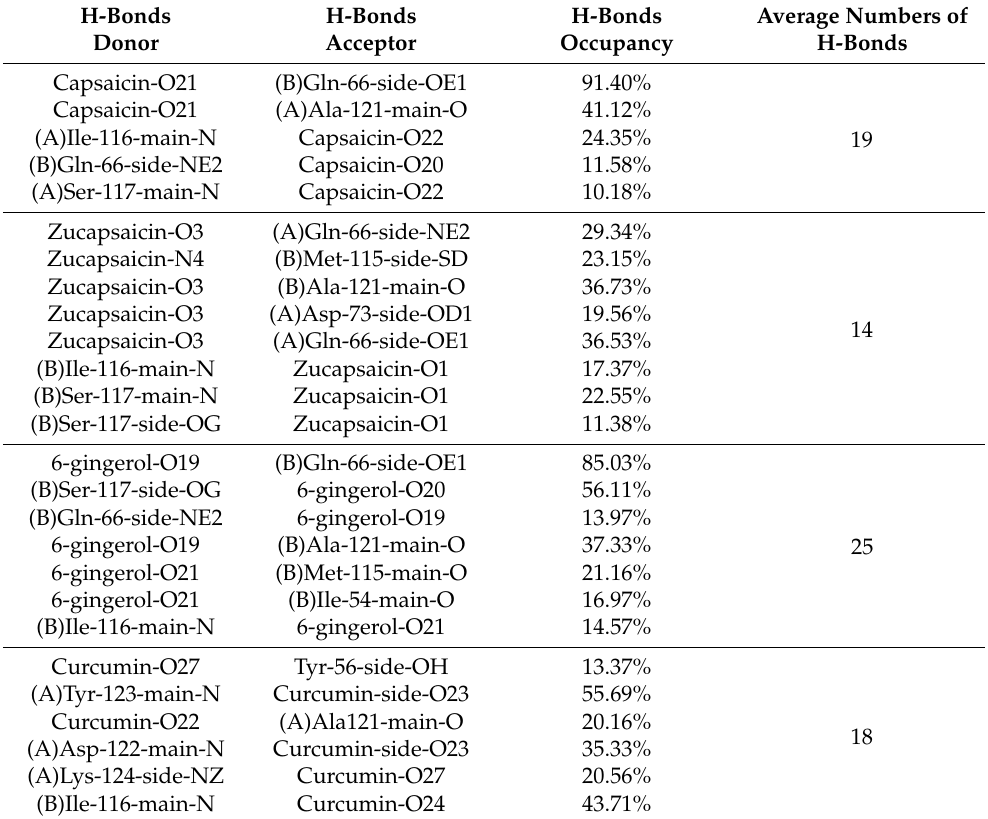
Table 7. The H-bonds occupancy of capsaicin, zucapsaicin, curcumin and 6-gingerol (-side is the sidechain of residue, -main is the mainchain of